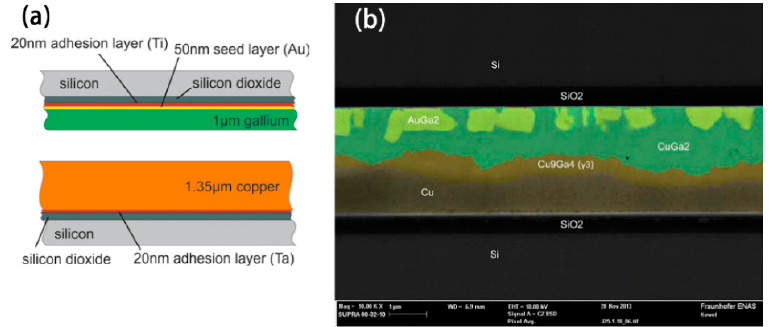
Figure 4. Low-temperature wafer bonding using solid-liquid inter-diffusion of Ga/Cu system [61]. ( a ) Schematic cross section of the interface prepared for the Ga/Cu bonding; ( b ) scanning electron microscopy (SEM) cross section of Ga/Cu bonded samples after annealing at 90 °C.